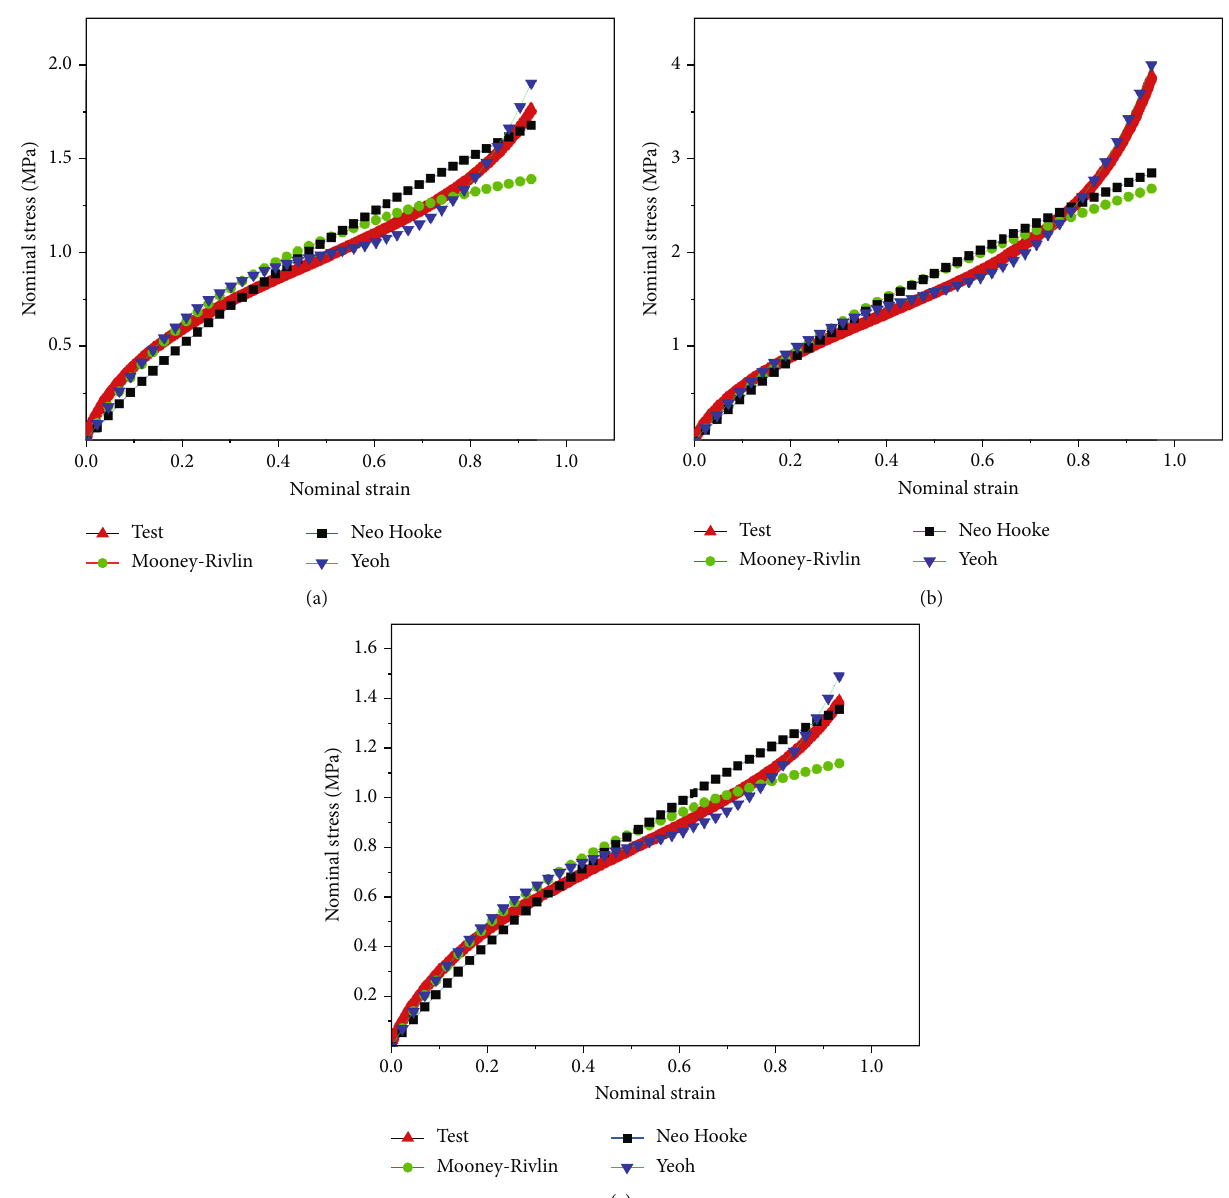
Figure 4: Three constitutive models fi tted for (a) Tread rubber, (b) Body rubber, and (c) Side